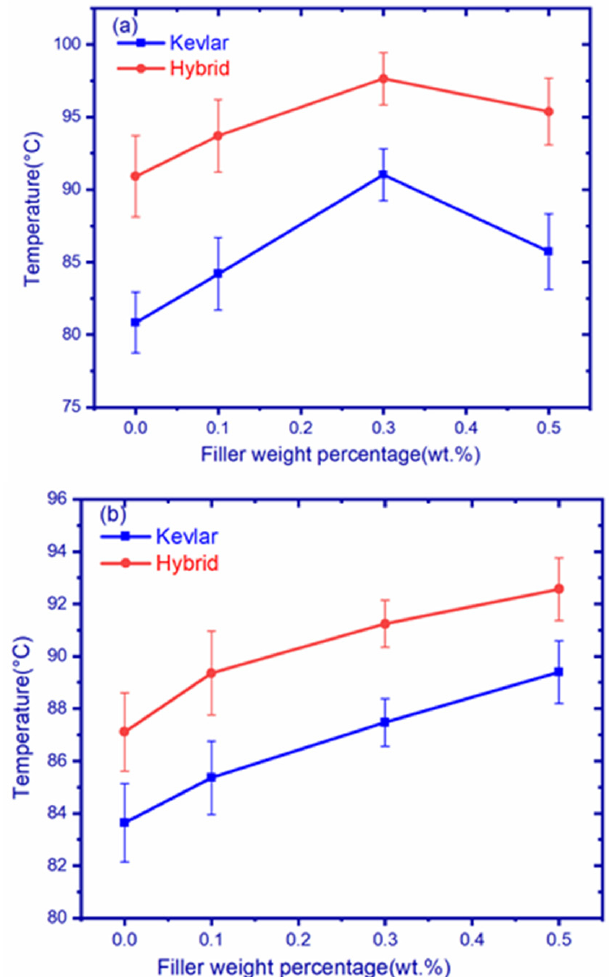
Figure 10. Heat deflection temperature of ( a ) graphene composites and ( b ) hBN composites. Heat deflection curves of hBN-filled composites are shown in Figure 10b, and the heat deflection temperatures of different composites are listed in Table 9. The figure indicates that hybrid–hBN fiber composites exhibited superior temperatures compared to Kevlar– hBN composites. The addition of hBN filler resulted in the continuous improvement of temperature in composites. hBH3 composites showed a maximum temperature of 92.57 ◦